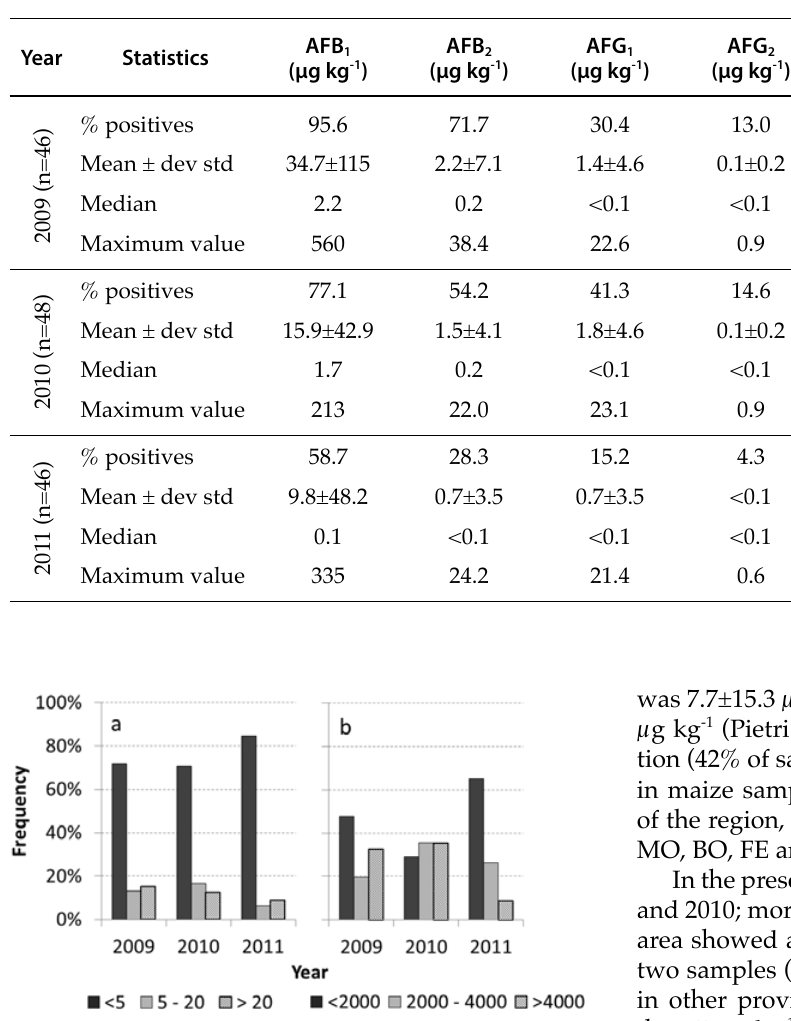
Table 2. Descriptive statistics of aflatoxins (AFB 1 , AFB 2 , AFG 1 and AFG 2 ), fumonisins (considered as the sum of FB 1 and FB 2 ), deoxynivalenol (DON) and zearalenone (ZEN) contamination (µg kg -1 ) for maize grain samples collected in Emilia- Romagna over the years 2009, 2010 and 2011.